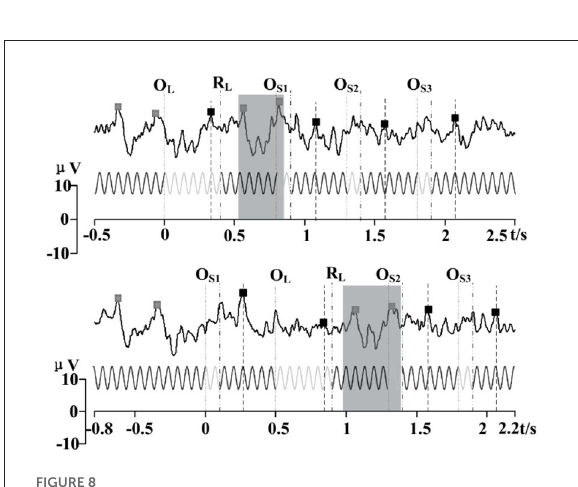
FIGURE8 Comparison of two kinds of orders for the stimuli with multi omission (64 trials). The Gray shaded area shows a similar response after the long omitting duration in a different order. The prominent peaks of EPR and OSP are marked with square